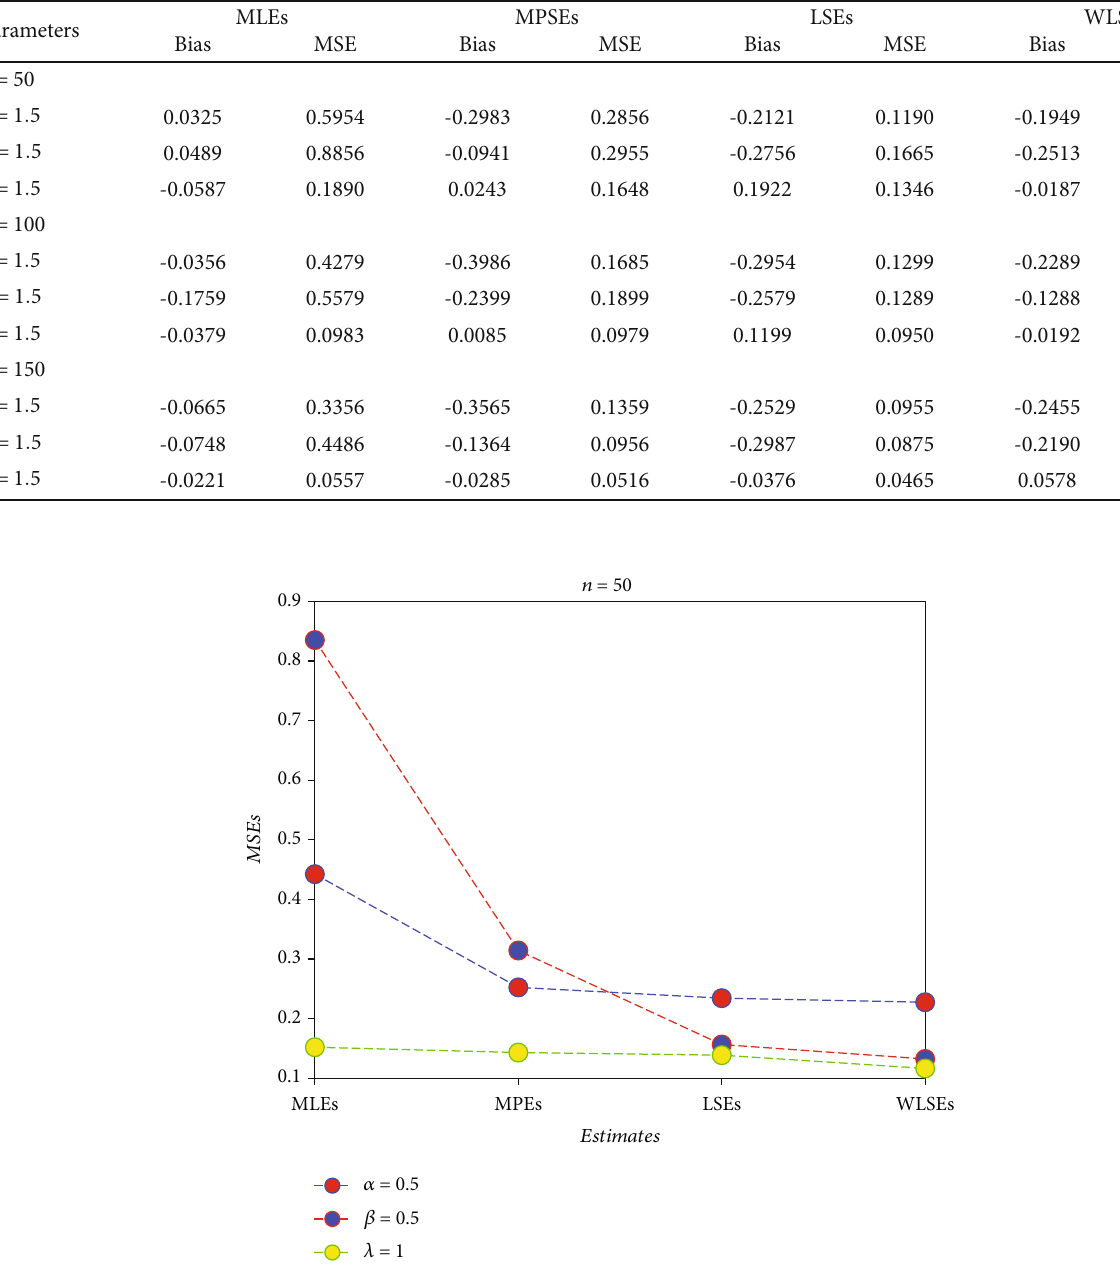
Figure 3: MSEs using n = 50 : α = 0 : 5 , β = 0 : 5 , and λ = 1